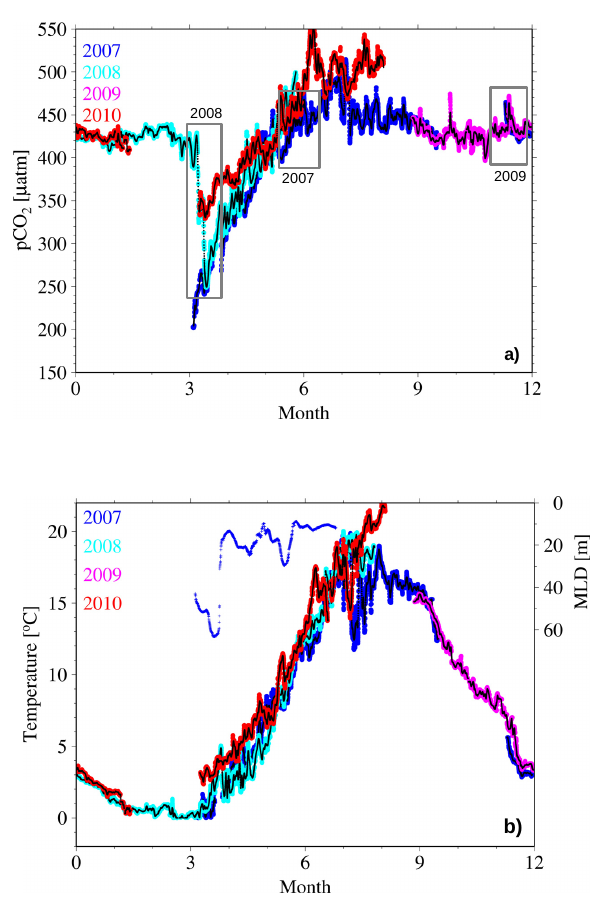
Fig. 1. Composite of available p CO 2 (a) and temperature data (b) for the years 2007–2010, recorded by the CARIOCA buoy. For the further study we evaluate data from June/July 2007, April 2008 and November/December 2009 as indicated by the grey boxes in (a) , as- suming a climatological annual cycle. The black lines indicate the 48-point moving average. In (b) , the depth of the maximum of the Brunt-V¨ais¨al¨a frequency is shown as measure of the mixed layer depth (MLD, blue crosses), computed from the SeaHorse data, de- ployed between April 2007 and July